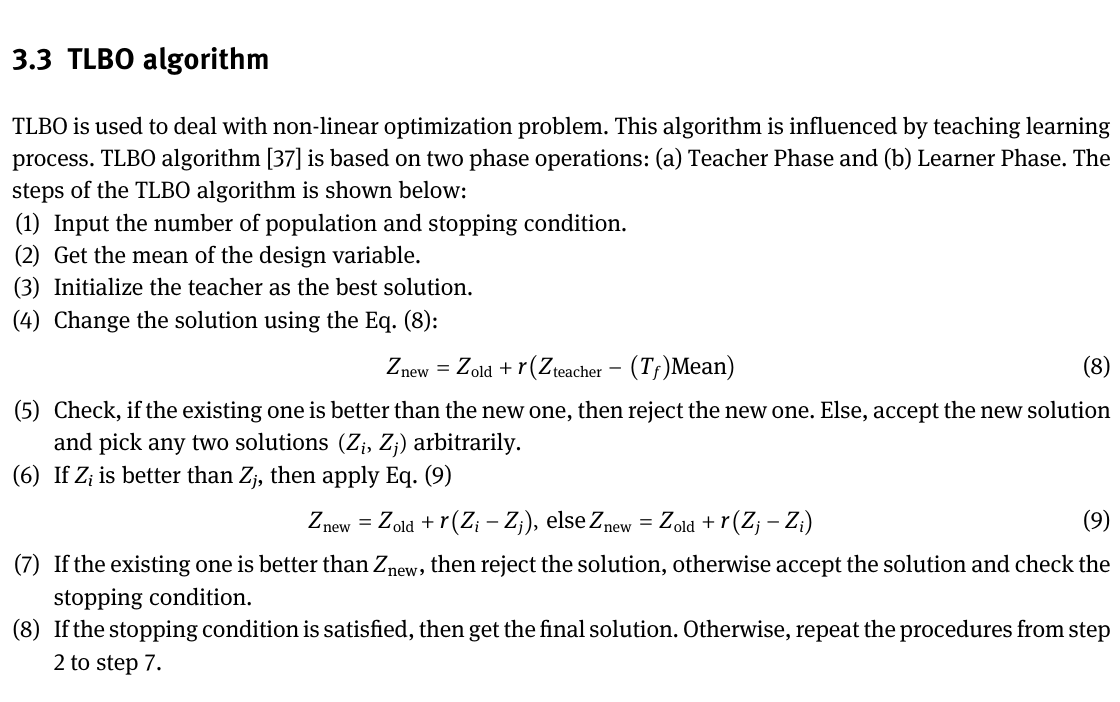
Figure 4: The basic architecture of